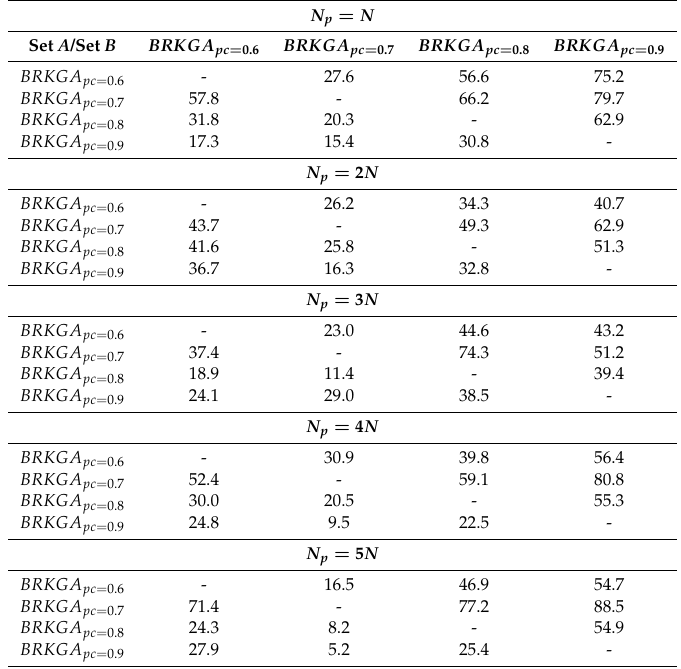
Table 1. Percentage of Non-dominated Solutions of set B covered by those in set A for case study 1. N p = N Set A /Set B BRKGA pc = 0.6 BRKGA pc = 0.7 BRKGA pc = 0.8 BRKGA pc = 0.9